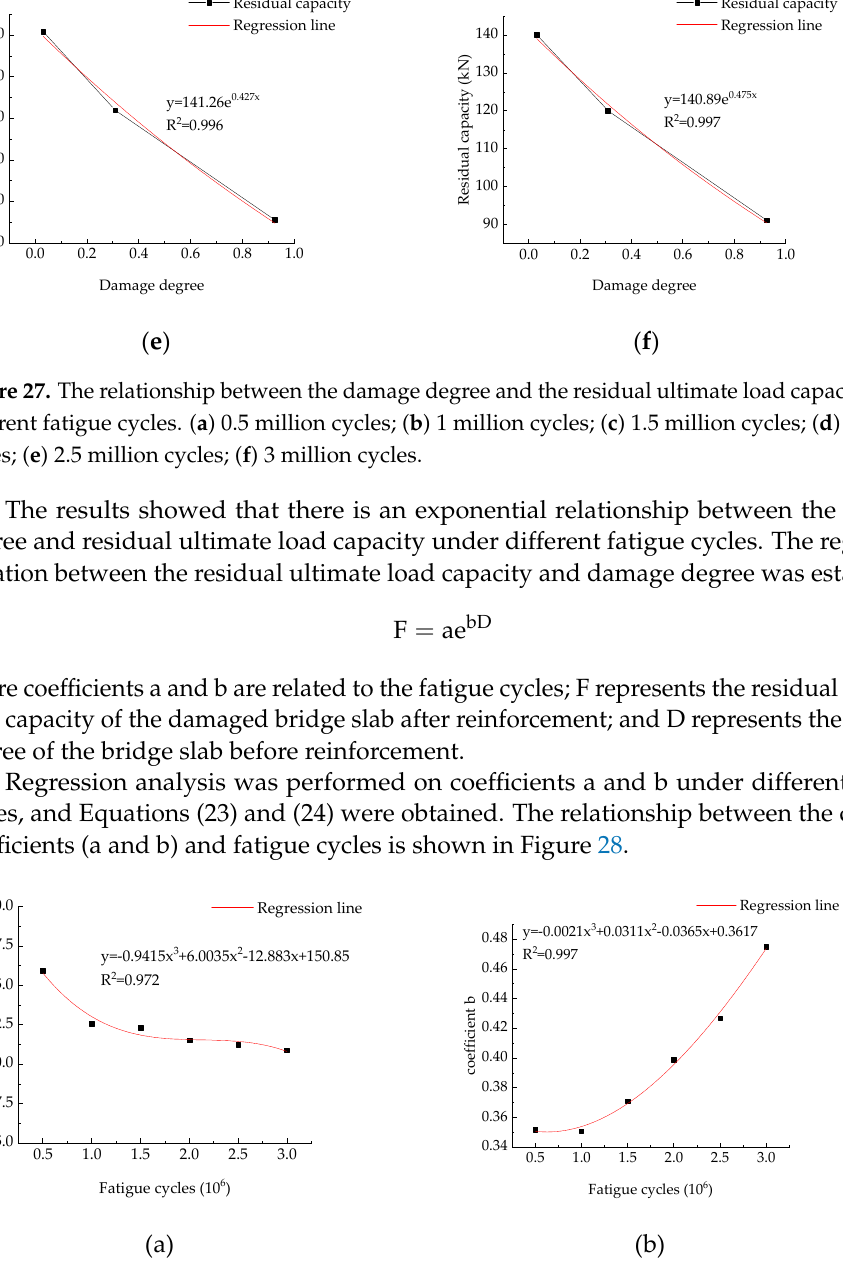
Figure 28. The relationship between the different coefficients (a and b) and fatigue cycles. ( a ) Coefficient a. ( b ) Coefficient b.